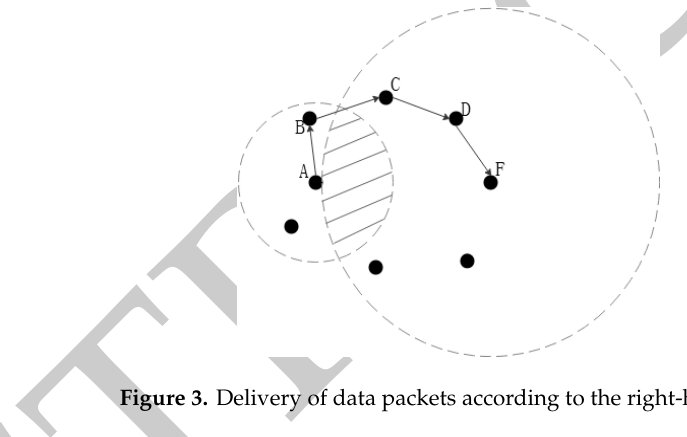
Figure 3. Delivery of data packets according to the right-hand rule.